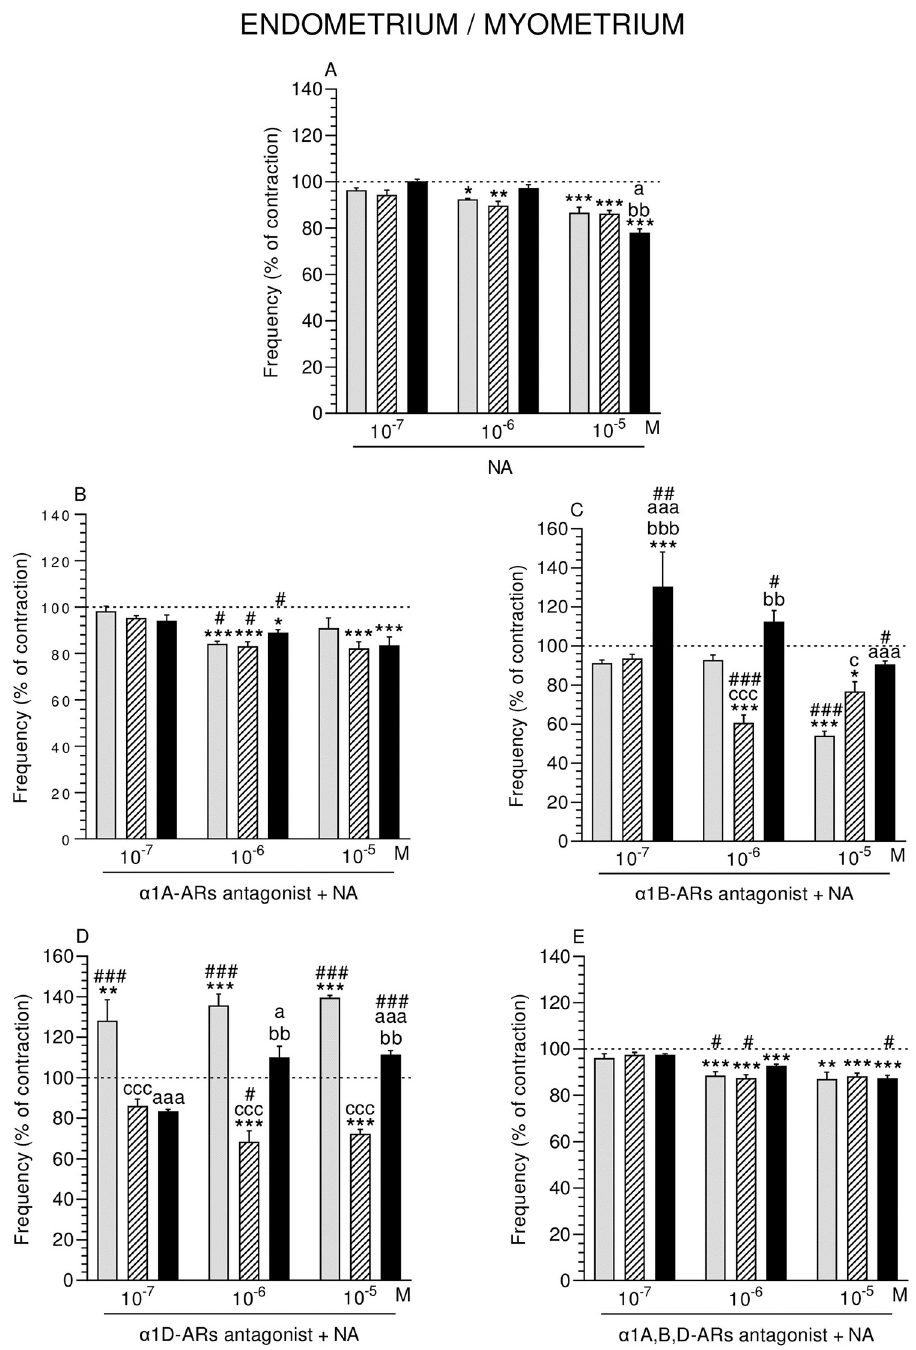
Fig 7. Effect of noradrenaline (NA) alone (A) and NA with α 1A- (B), α 1B- (C), α 1D- (D) and α 1A,B,D (E)– adrenoreceptors (ARs) antagonists (a dose of 10 − 4 M) on the frequency of contractions in pig endometrium/ myometrium strips obtained from the CON (grey bars), SAL (hatched bars), and E . coli (black bars) groups. Data from five experiments (gilts, in each group). Effects of particular doses of NA and antagonists are expressed as percentage (mean ± SEM) in relation to the basal (pre-treatment period) contractile frequency, established as 100% (horizontal lines). � P < 0.05, �� P < 0.01, ��� P < 0.001—indicate differences from baseline in each group; a P < 0.05, aaa P < 0.001- indicate differences between CON and E . coli groups for the same treatment; bb P < 0.01, bbb P < 0.001— indicate differences between SAL and E . coli groups for the same treatment; c P < 0.05, ccc P < 0.001—indicate differences between CON and SAL groups for the same treatment; # P < 0.05, ## P < 0.01, ### P < 0.001 compared between particular antagonist with NA effect versus NA effect alone for the same group/NA